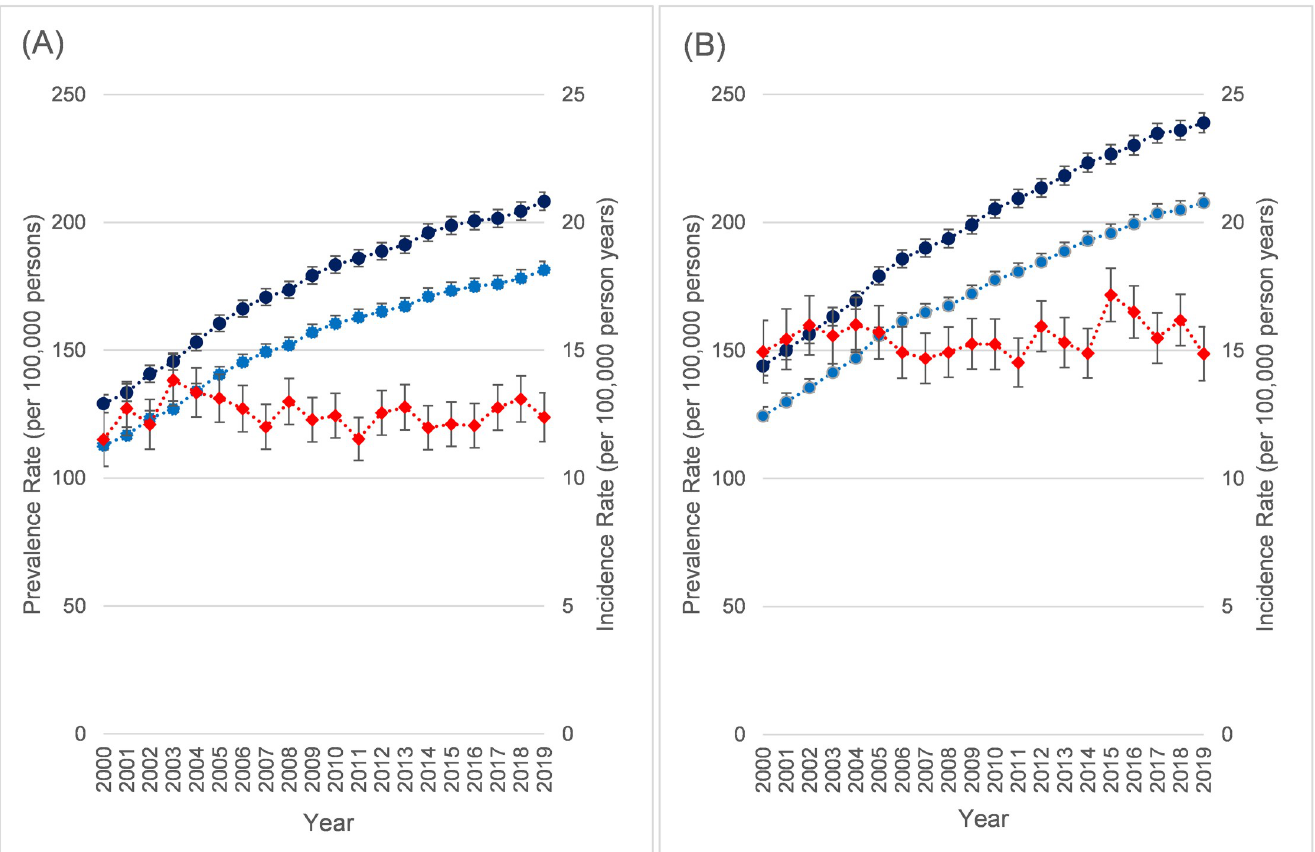
Fig 2. Prevalence and incidence rates per 100,000 persons in neuromuscular disease 2000–2019. (A) Females. (B) Males. Dark Blue = Lifetime prevalence rate per 100,000 persons. Light Blue = Lifetime prevalence rate per 100,000 persons excluding Guillain-Barre´ syndrome codes not recorded in previous 5 years. Red = Incidence rate per 100,000 person-years. Both rates age standardised to CPRD population as of 1/1/2019. 95% confidence intervals shown for each.